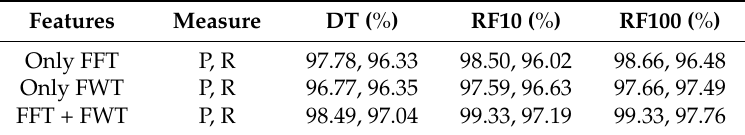
Figure 6. True positive ( TP ), true negative ( TN ), false negative ( FN ), and false positive ( FP ) for the approach with spectral and wavelet features. Table 1. Comparisons between different classifiers using different feature compositions. DT, decision tree; RFn, random forest with n DTs; P, precision; R, recall. The results are based on the work in [9].